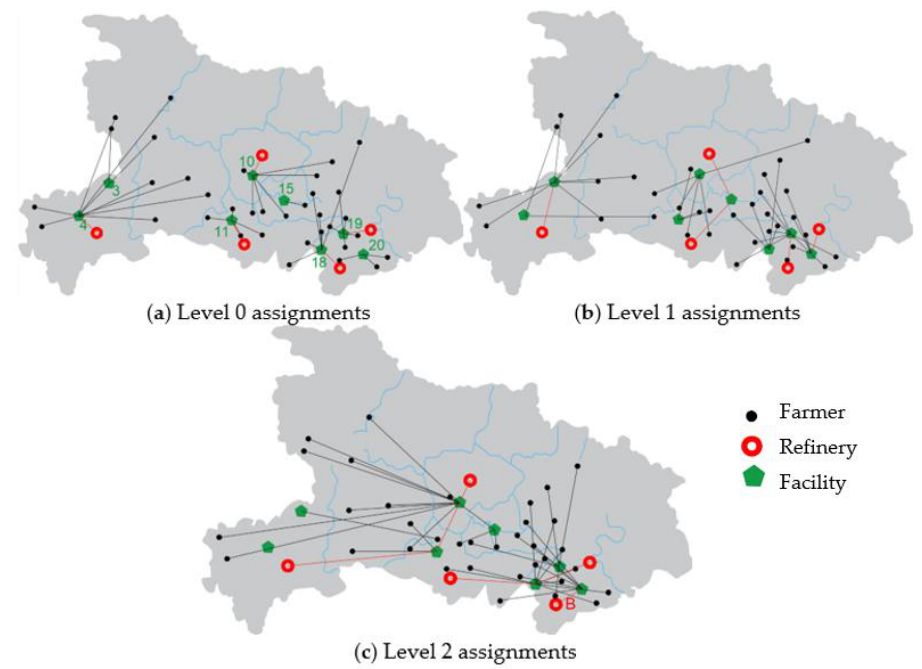
Figure 6. Facility locations and assignments. ( a ) Level 0 assignments; ( b ) Level 1 assignments; ( c ) Level 2 assignments.